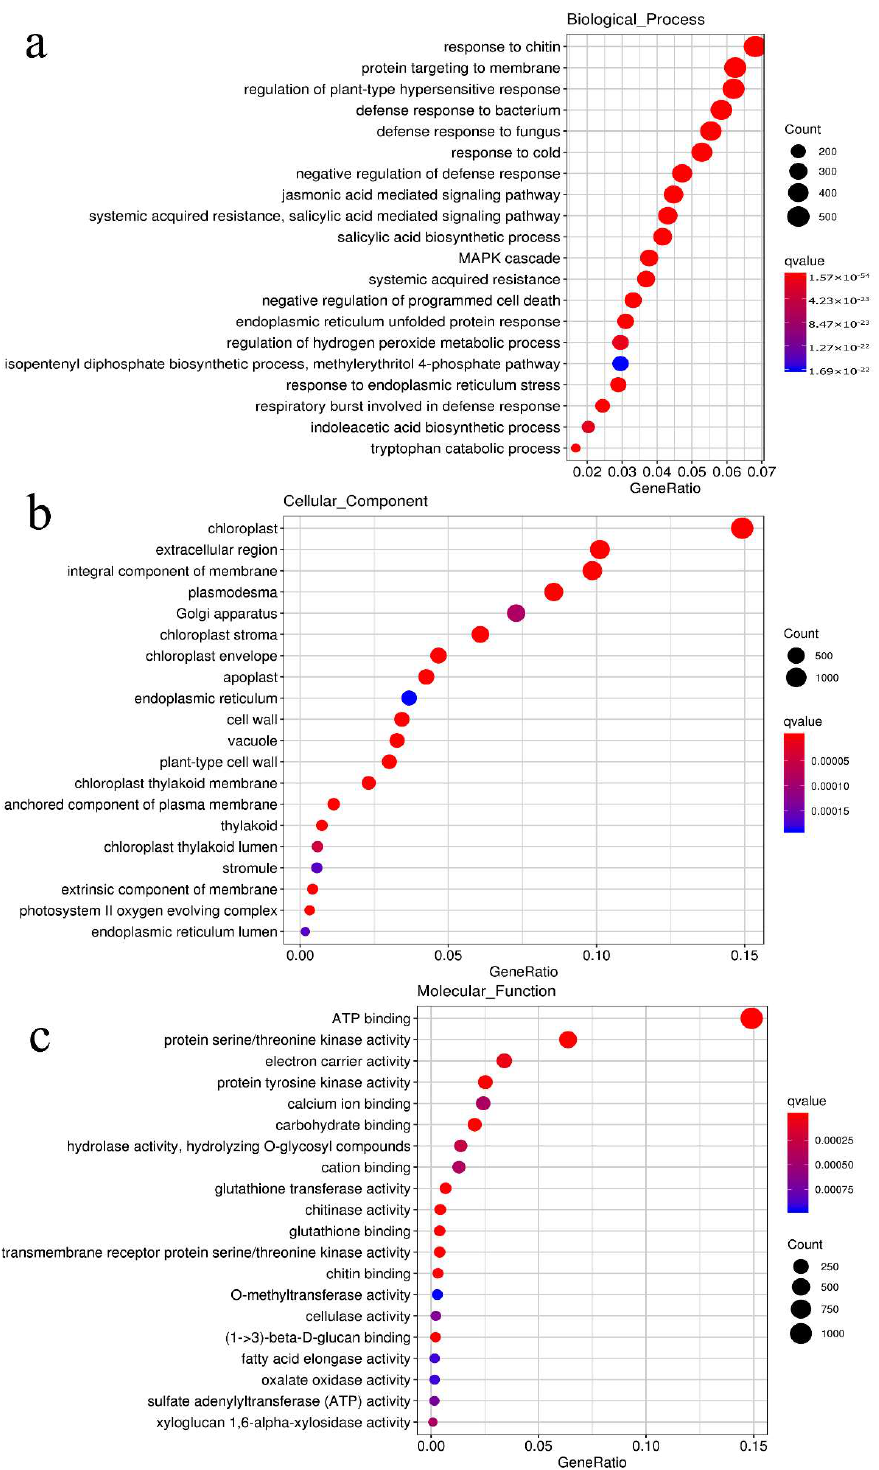
Figure A2. Dot plot of enrichment of GOs in biological processes ( a ), cellular components ( b ) and molecular function ( c